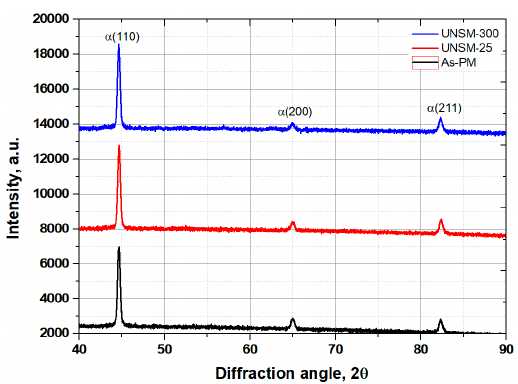
Figure 8. XRD patterns derived from the as-PM, UNSM-25 and UNSM-300 samples. Table 4. FWHM (Full width at half maximum) values of the martensitic (200) martensitic peak. As-PM